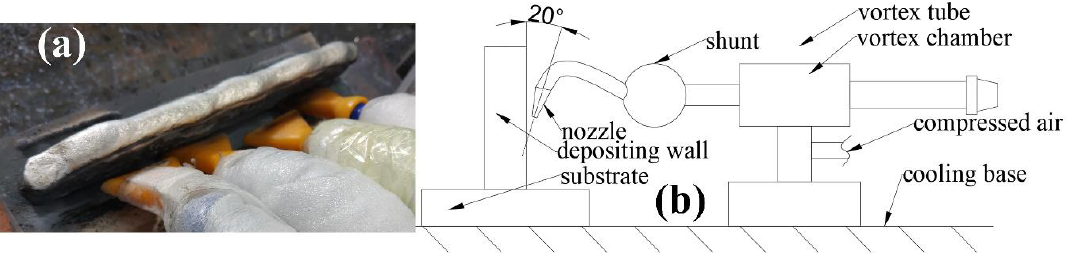
Figure 2. Vortex cooling system: ( a ) physical diagram, ( b ) schematic diagram. Table 3. Process parameters of the vortex tube.